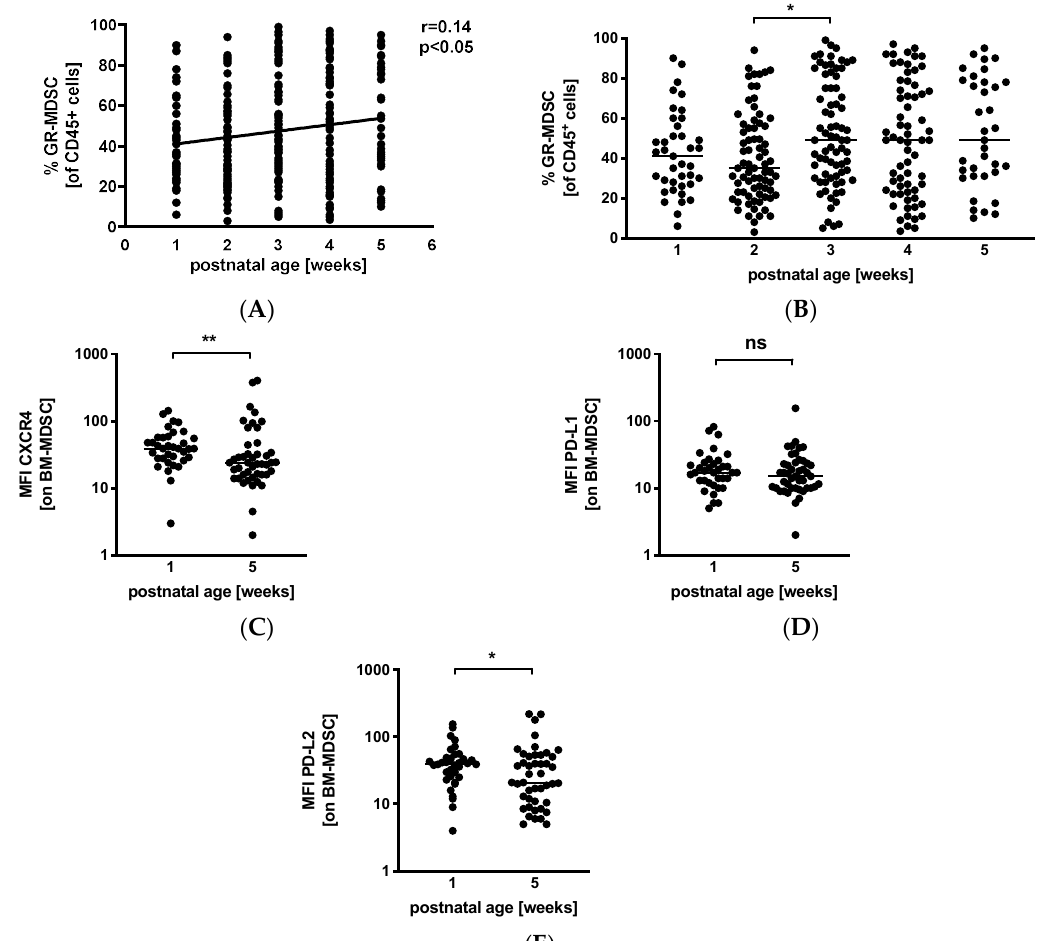
Figure 2. Quantification of GR-MDSC in breast milk of preterm infants (dependency on postnatal age). Milk cells were isolated from breast milk of mothers of preterm infants during the first five weeks of life. Percentages of GR-MDSC of total CD45+ leucocytes and the expression of activation markers CXCR4, PD-L1, and PD-L2 on BM-MDSC were determined by flow cytometry. ( A ) Scatter diagram showing the percentage of GR-MDSC from total milk leucocytes depending on postnatal age. Regression line shows the correlation between percentages of BM-MDSC and postnatal age. n = 288, * p < 0.05, Spearman correlation. ( B ) Scatter diagram showing the percentage of BM-MDSC in BM of mothers of preterm infants in postnatal weeks 1–5. n = 35–74, * p < 0.05; Kruskal–Wallis test and